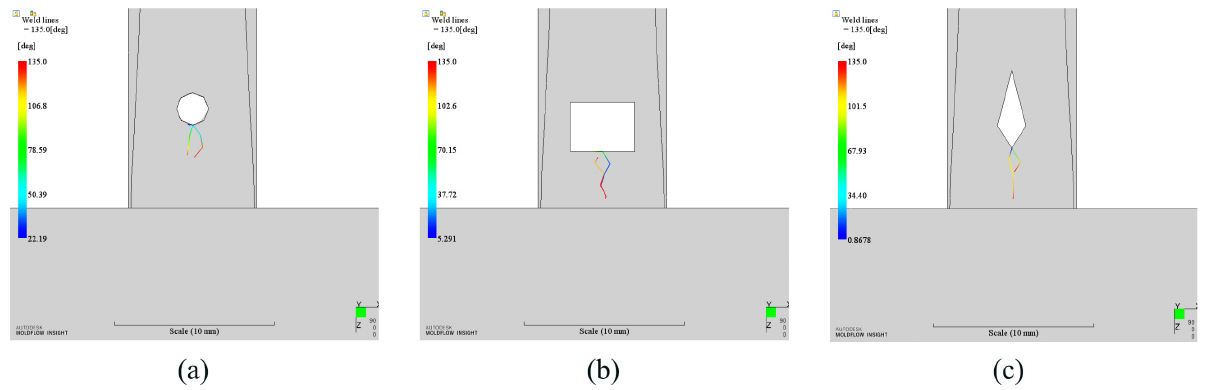
Figure 14. Weld lines results of different shapes. ( a ). Circular insert (optimized); ( b ). Rectangular insert (optimized); ( c ). Diamond insert (optimized).